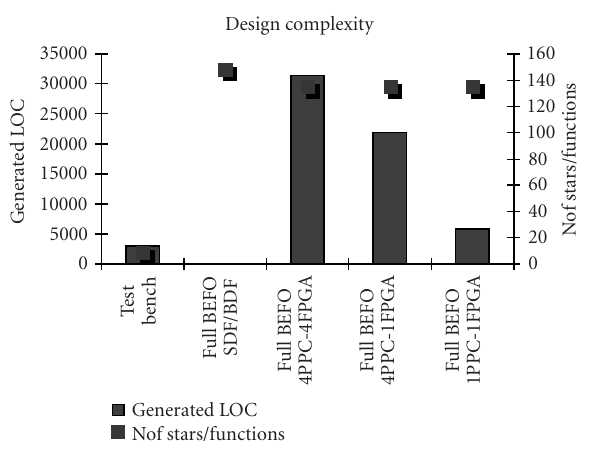
Figure 14: Design complexity of the RADAR benchmark imple- mented on the heterogeneous